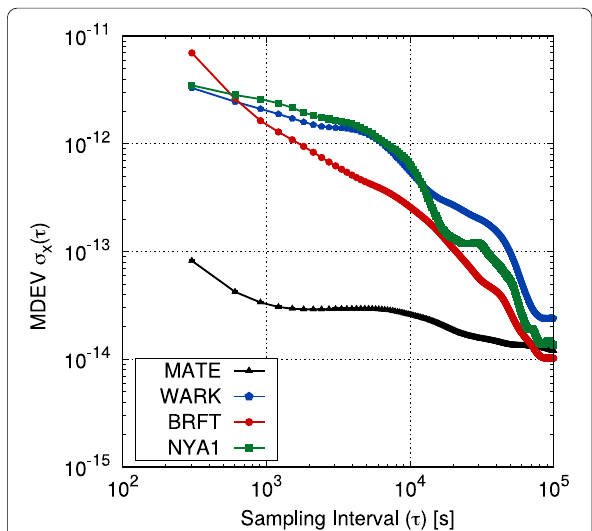
Fig. 3 Frequency stability of GPS receivers on the basis of the calculated MDEV statistics for four GPS stations. The figure includes the badly performing receivers (WARK, BRFT, NYAL) and a well performing clock (MATE), which represents a general performance of other GPS receivers used in this